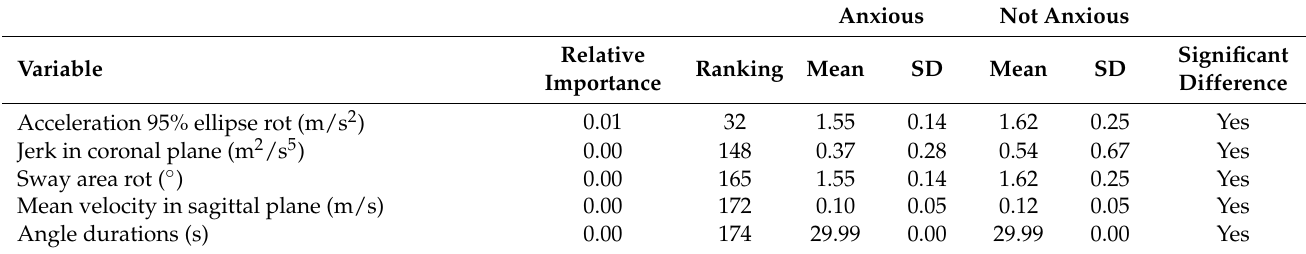
Table 3. Significant variables only for Eyes Closed, Feet on Ground.